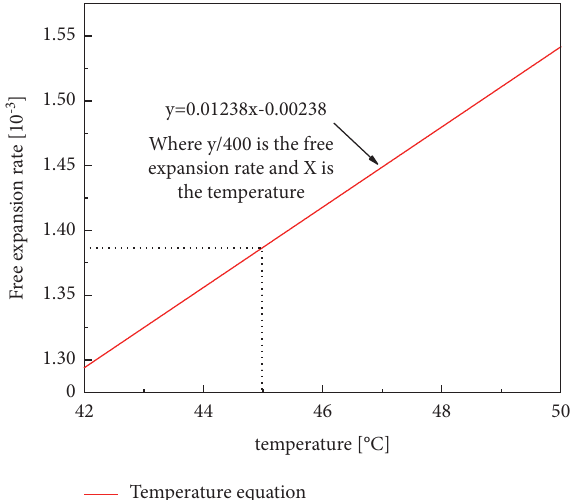
Figure 10: Comparison of test results and FE